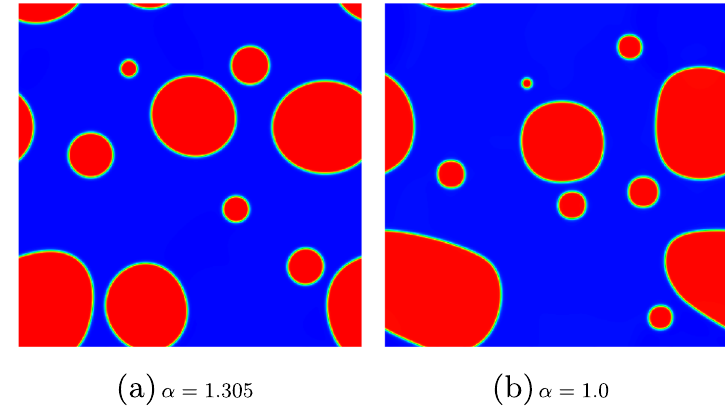
Fig. 15 Snapshots of the spinodal decomposition process, τ = 0.3 , T r = 0.8 , t = 20000